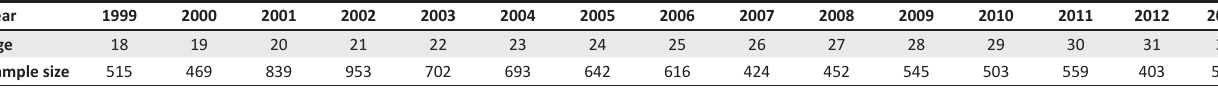
TABLE 1: Sample of respondents.